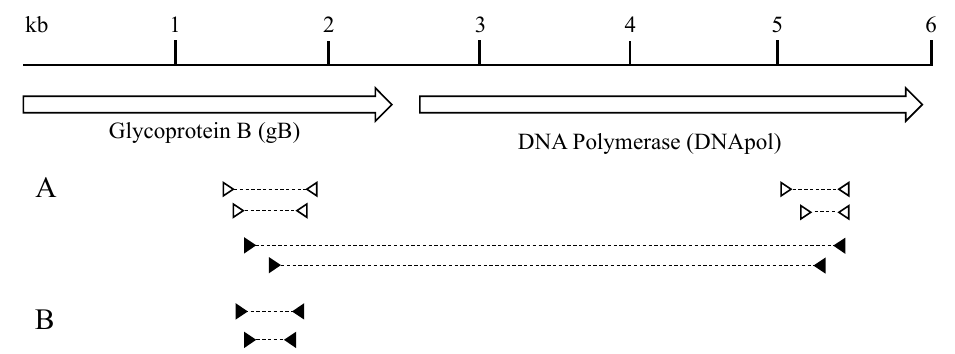
Figure 1. PCR strategy. ( A ) Nested primer sets are indicated by triangles, with their respective PCR products indicated with a dashed line. Open triangles indicate degenerate primers that were not designed in this study, while closed triangles indicate virus-specific primers designed in this study. Degenerate primer sets were used for initial detection of novel GHVs and their sequences were used to design the virus-specific primers. Virus-specific primers were used to amplify an extended 3.4 kb portion of the viral genome. ( B ) LcaGHV1 screening primers. Nested primers were designed using the gB coding sequence. Arrows indicate the gB and DNApol coding sequences (Figure adapted from Troyer et al. [22]).